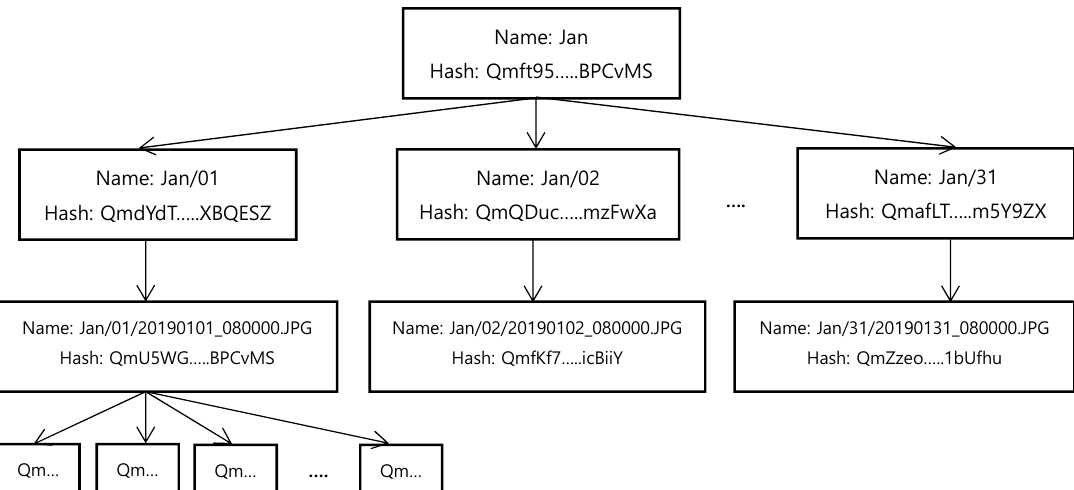
Figure 9 . The Merkle link of folder Jan from the SN-4000 Instrument. Figure 9. The Merkle link of folder Jan from the SN-4000